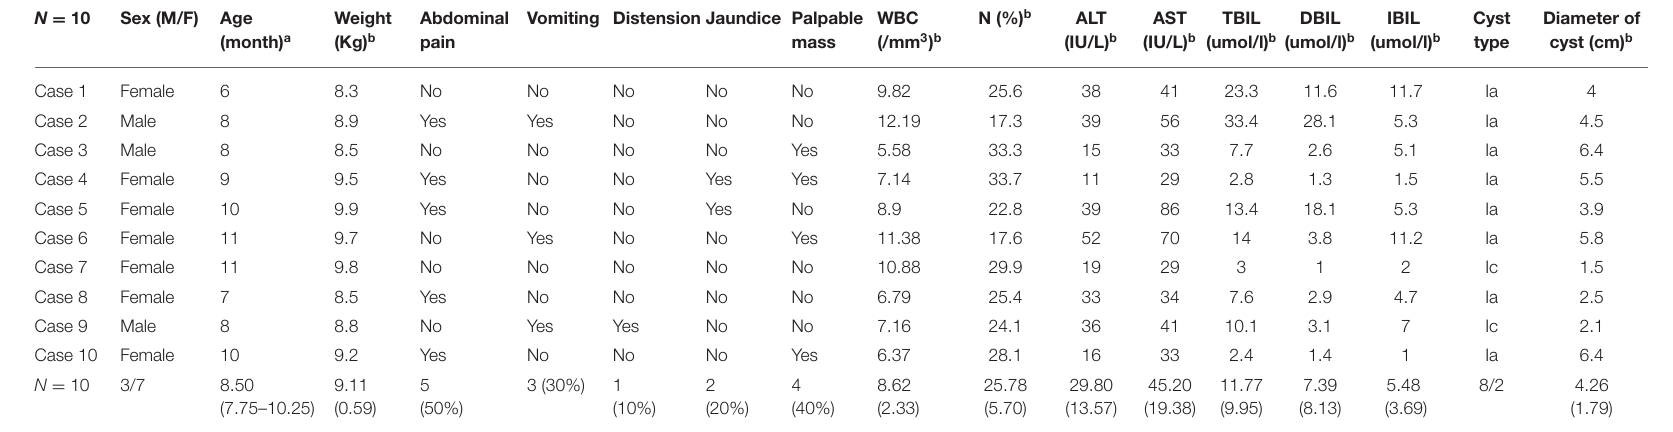
TABLE 1 | Characteristics of the patients.